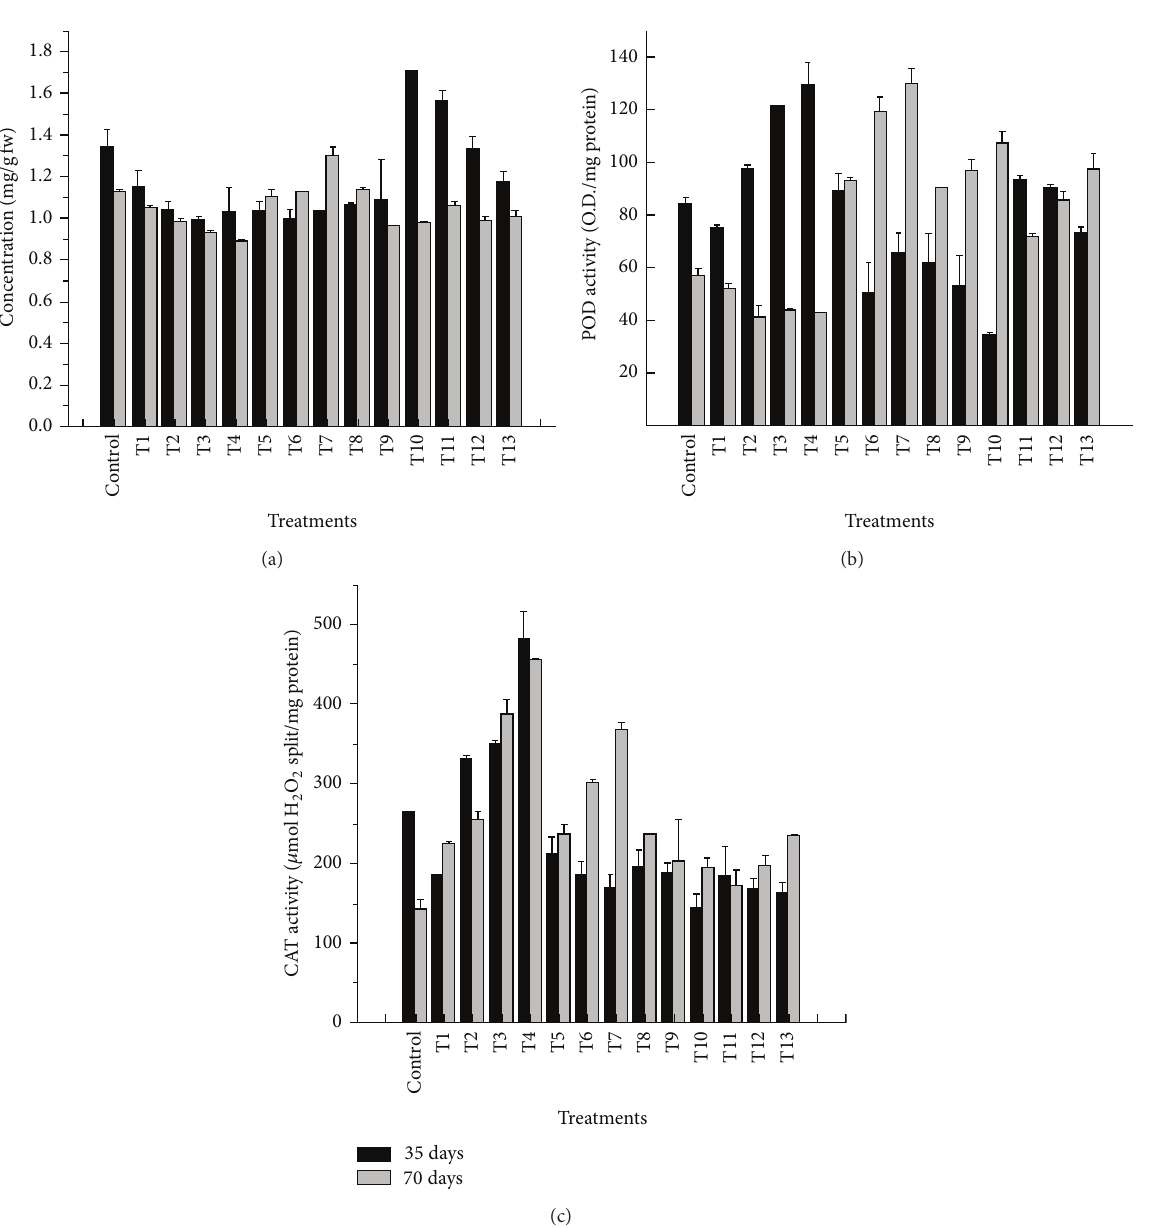
Figure 2: Accumulation of (a) protein and altered (b) peroxidase and (c) catalase activity in V. mungo under TE stress.